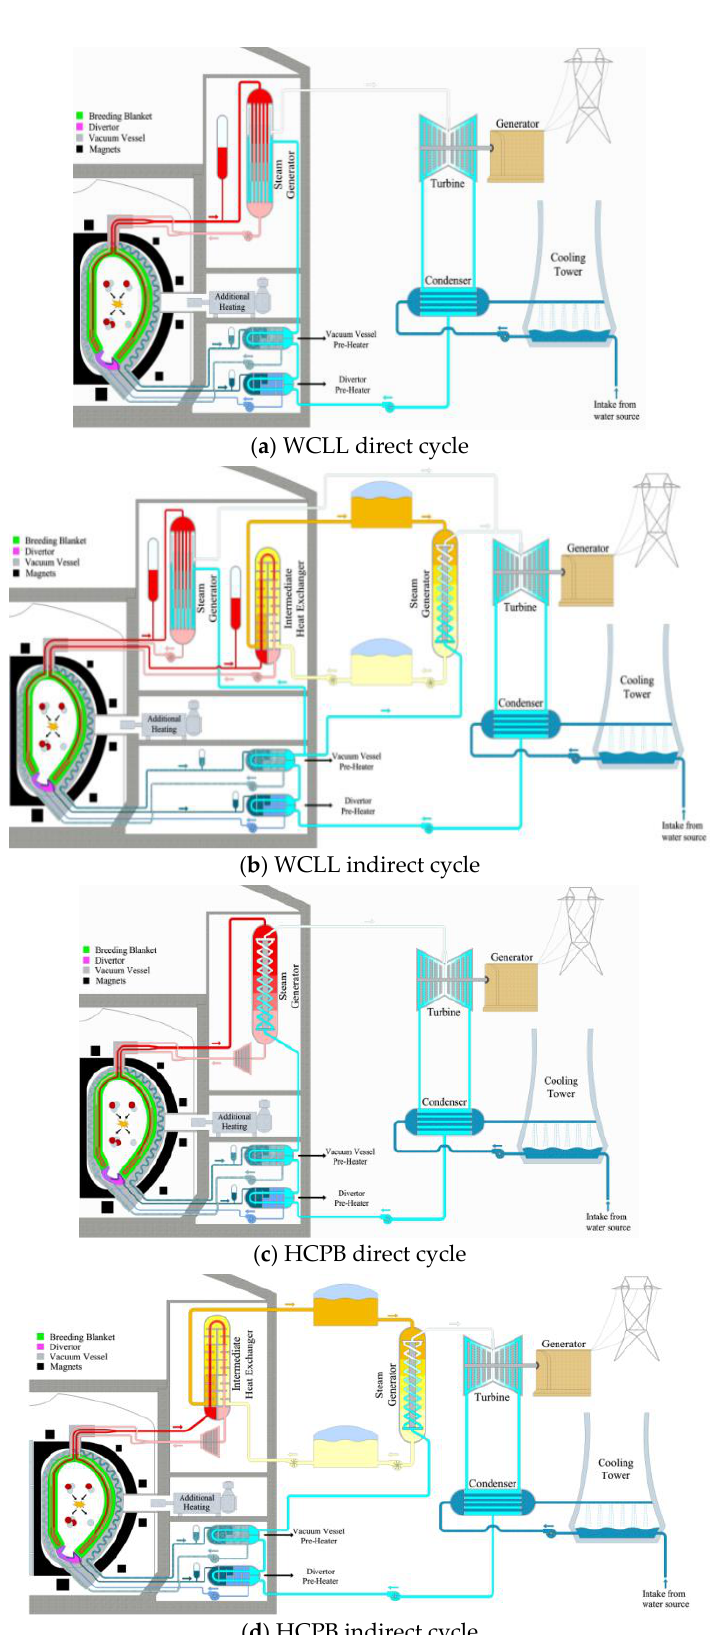
Figure 2. The four possible PHTS-PCS configurations that are under evaluation for the DEMO